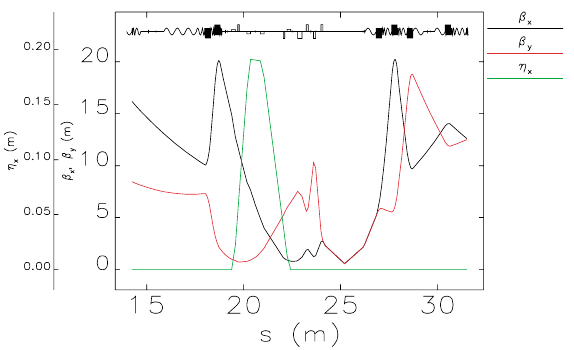
FIG. 3. (Color) Typical Twiss parameters in the chicane region. FIG. 4. (Color) Horizontal normalized emittance versus R 56